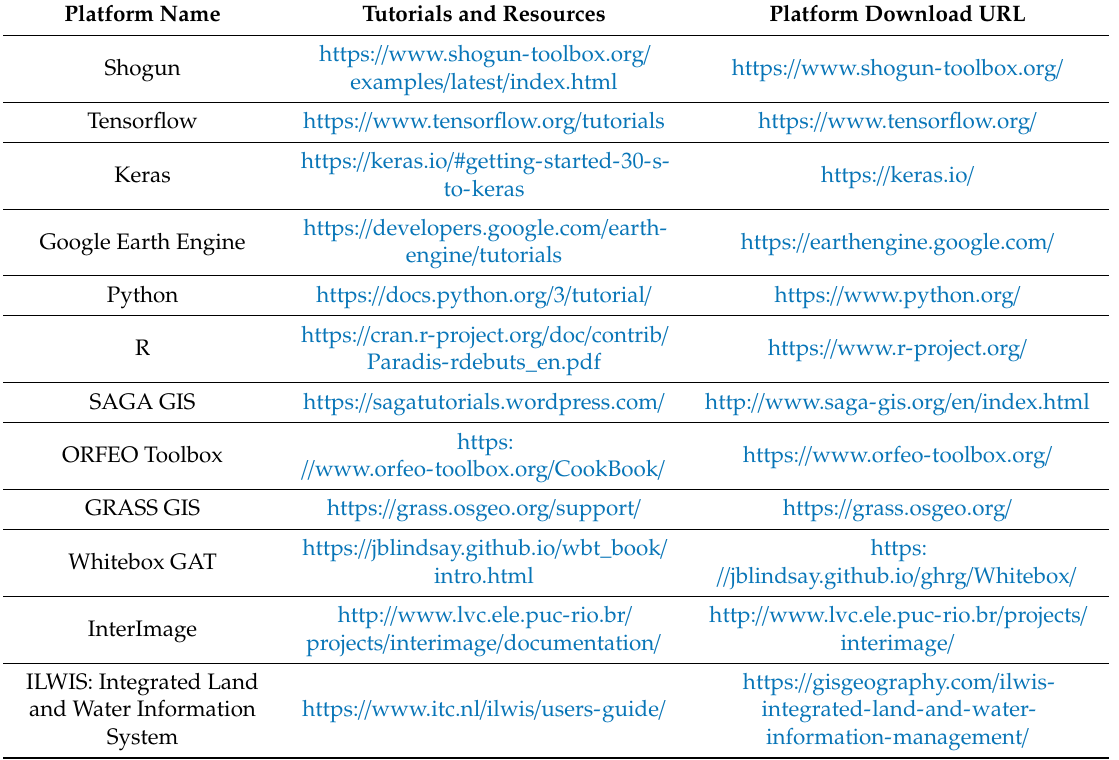
Table 2. Some open-source resources for machine learning and computer-automated